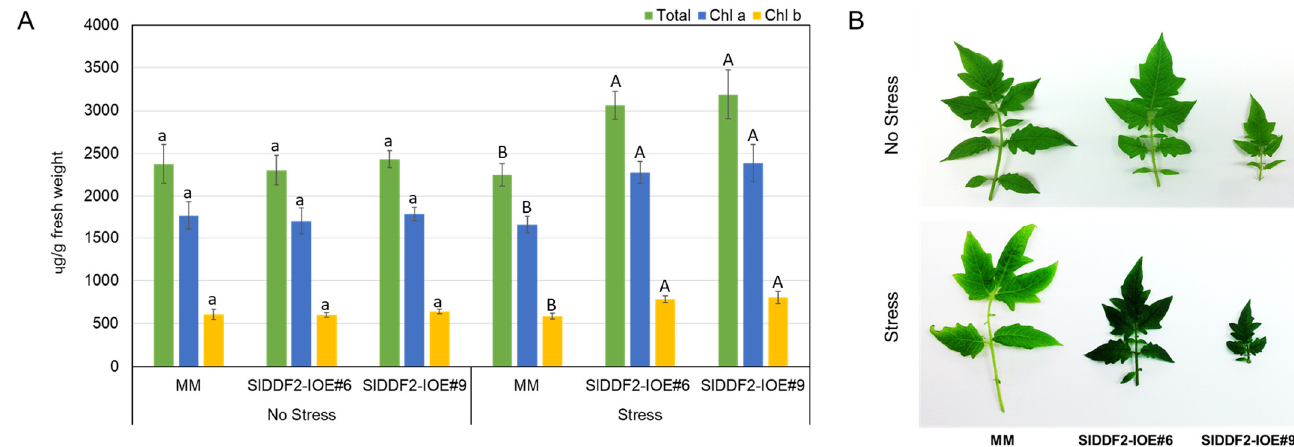
Figure 4. ( A ) Total chlorophyll (green), Chlorophyll a (blue), and Chlorophyll b (yellow) contents in MM and SIDDF2-IOE#6 and SIDDF2-IOE#9 transgenic plants in response to water withholding for seven days or no stress conditions; ( B ) detached leaves from stressed and nonstressed wild-type plants and the two transgenic lines plants. Values are the means ± SD. Different lower-case letters indicate a significant difference between transgenic and wild-type plants under nonstressed conditions, and different capital letters indicate a significant difference between transgenic and wild-type plants under stress conditions ( p < 0.05).